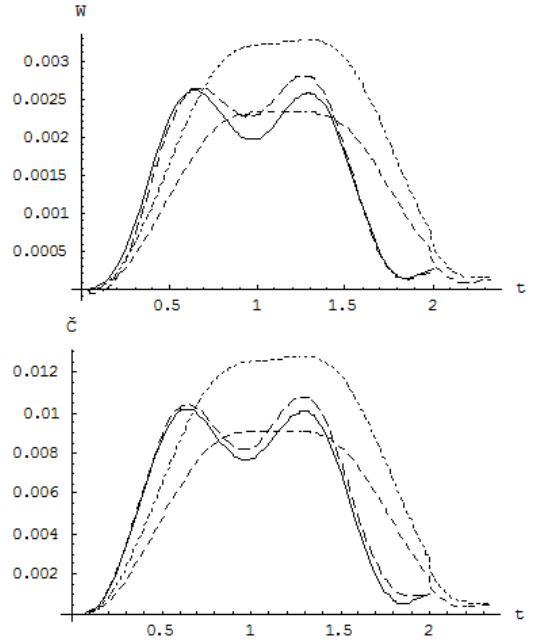
Figure 38: The vertical-torsional motion of the middle of the bridge, for R = 150 m, d = 5 m, e H = 3.00 m, e V = 1.20 m, υ = 30 m/s, un- der the action of a Damped load ( __ ), Simple load ( _ _ ), Damped vehicle (- - - ), Simple vehicle (. . .